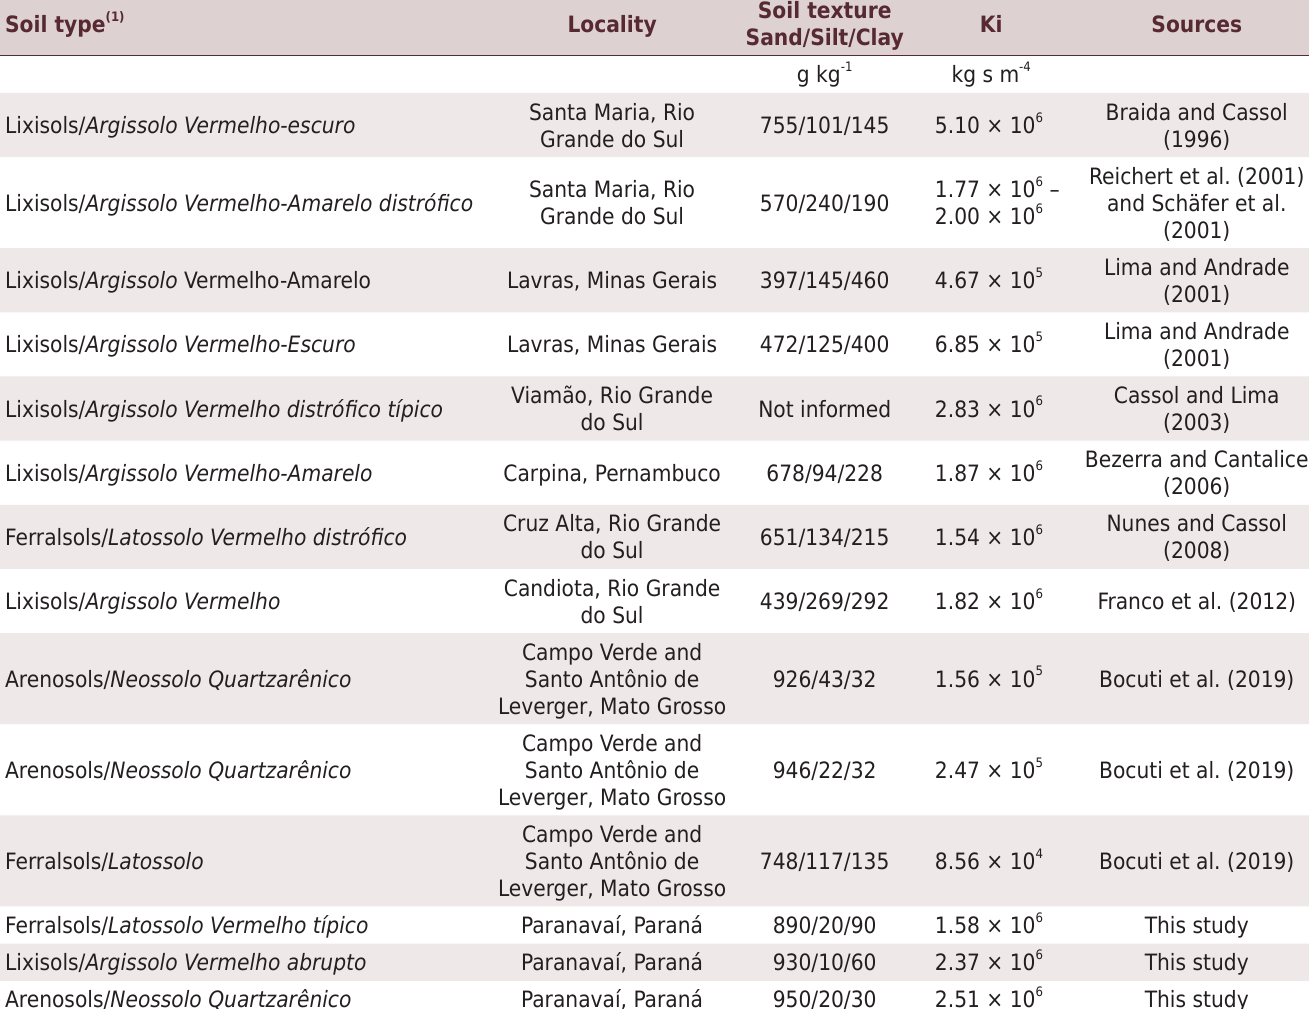
Table 4. Interril erodibility of some Brazilian sandy soils Soil type